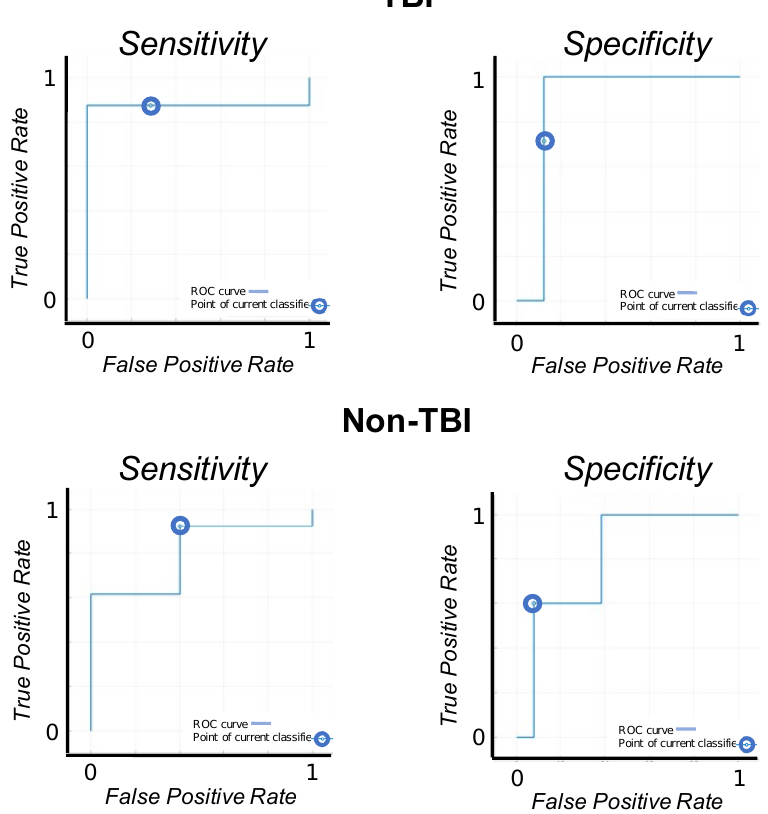
Figure 4. ROC curves. The ROC curves for sensitivity and specificity of the linear discriminant analyses on the patients’ clinical outcome (TBI vs. non-TBI patients).